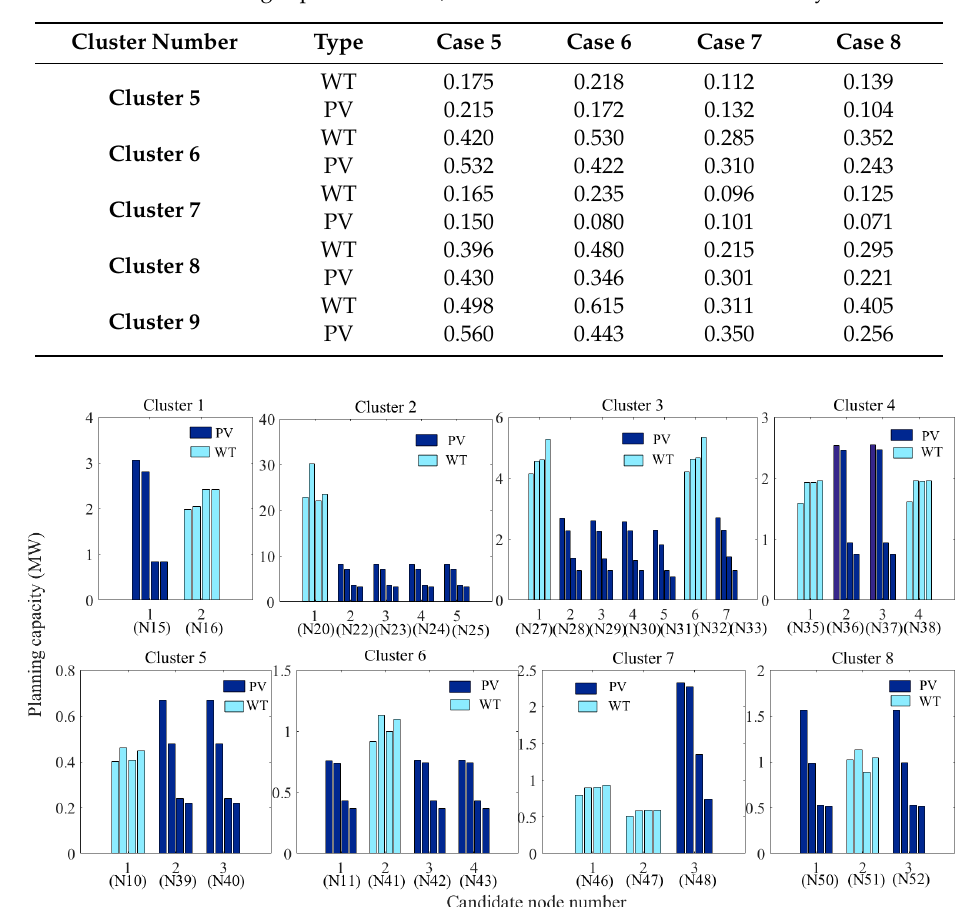
Figure 11. Comparison of the optimal capacities of the PVs/WTs of substations in each cluster of the actual network.